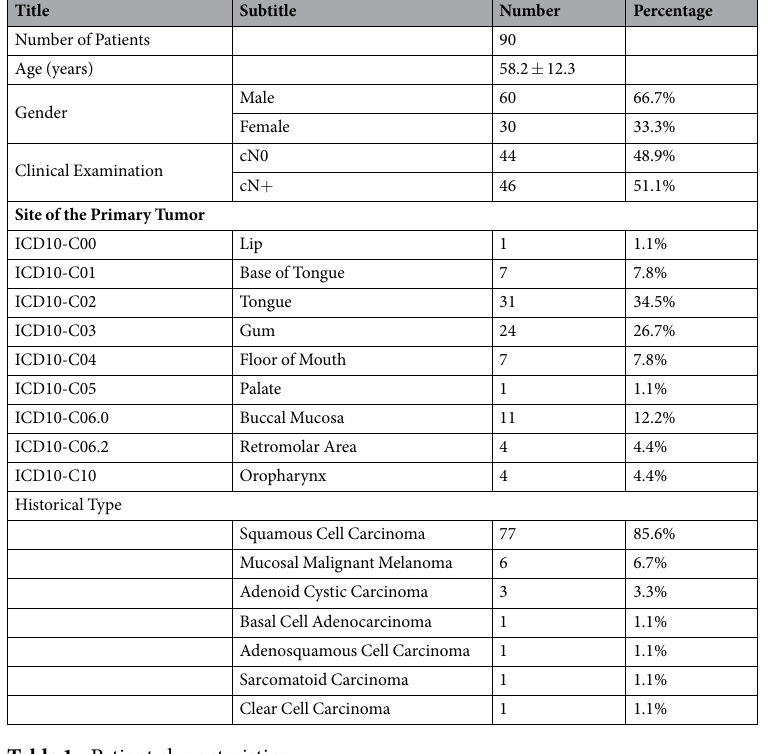
Table 1. Patient